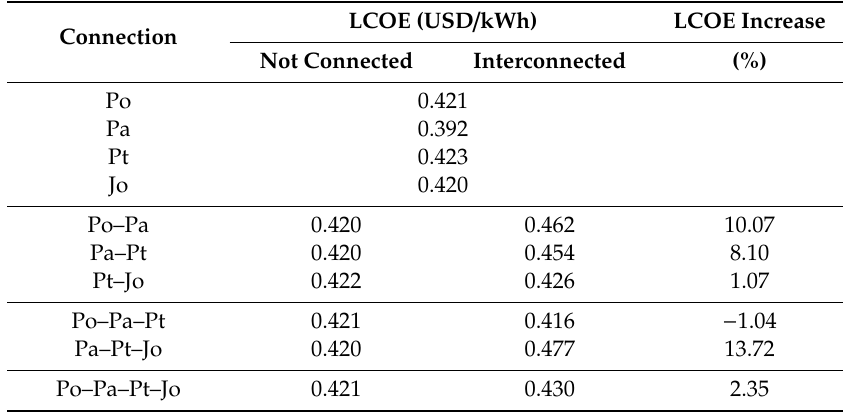
Table 8. LCOE of the decentralized and clustered HRES simulations from HOMER Pro.